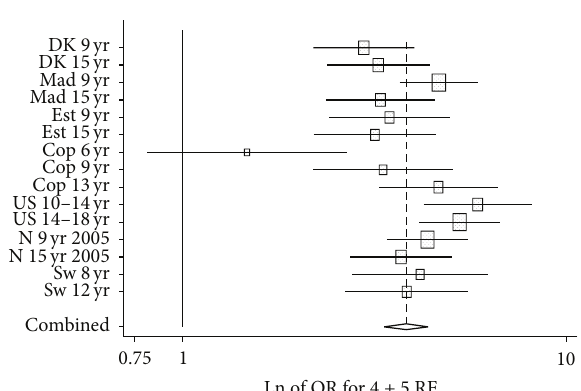
Figure 1: Odds ratios of observed number of children with 4 or 5 risk factors divided with expected number for each